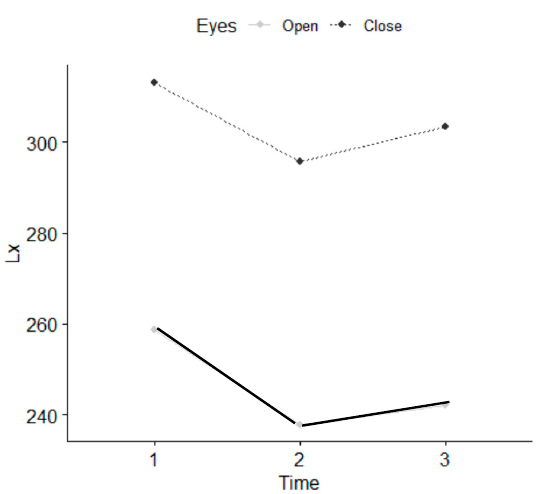
Figure 6. Length in (Lx) parameter 1 (T0 before), 2 (T1 immediately), 3 (T2 7–10 days).